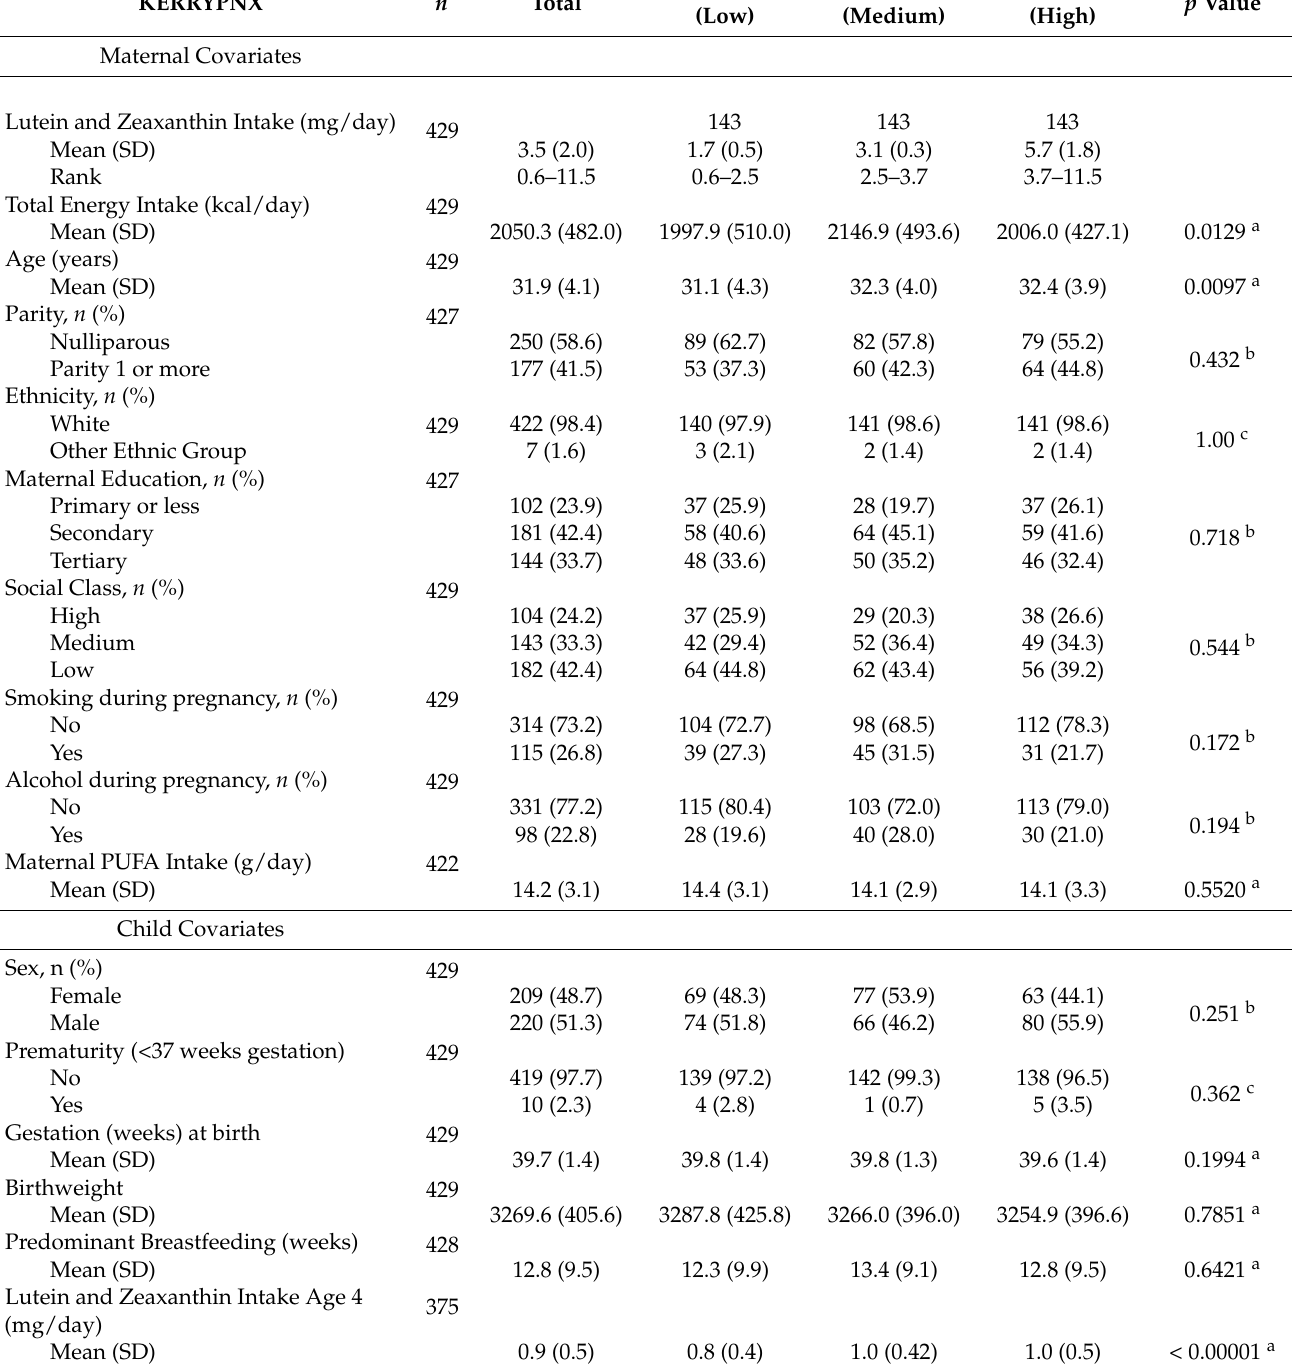
Table 1. Baseline characteristics of participants according to tertile of lutein and zeaxanthin (L&Z) consumption during the first trimester (12-week assessment) of pregnancy. Based on the Sabadell cohort of the Spanish Childhood and Environment (INMA)